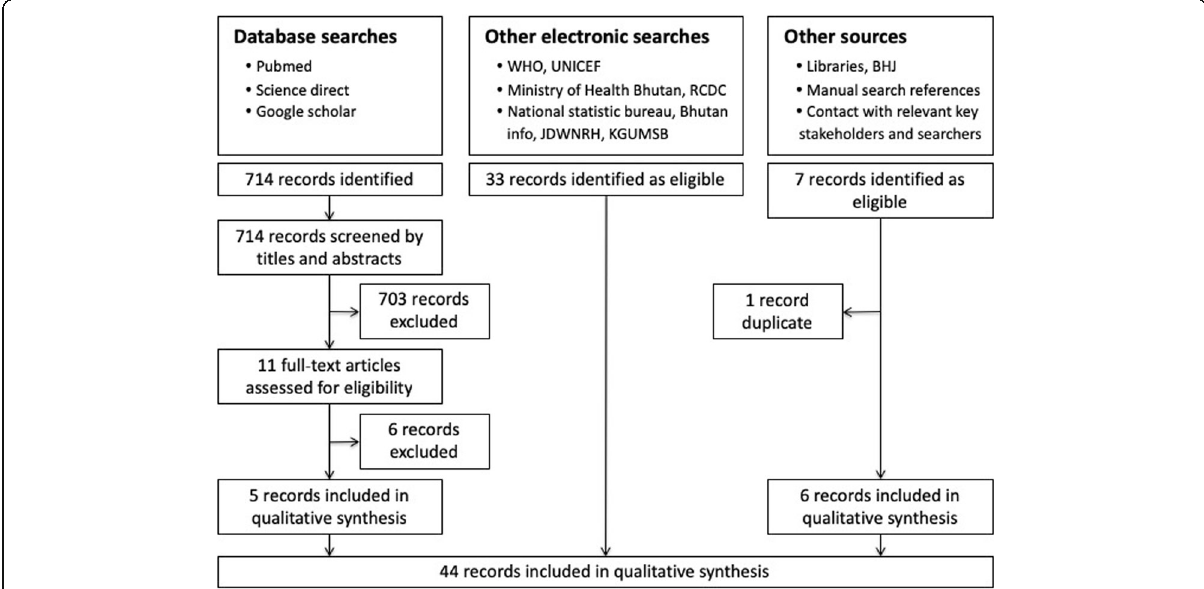
Fig. 1 Flow diagram illustrating the selection of